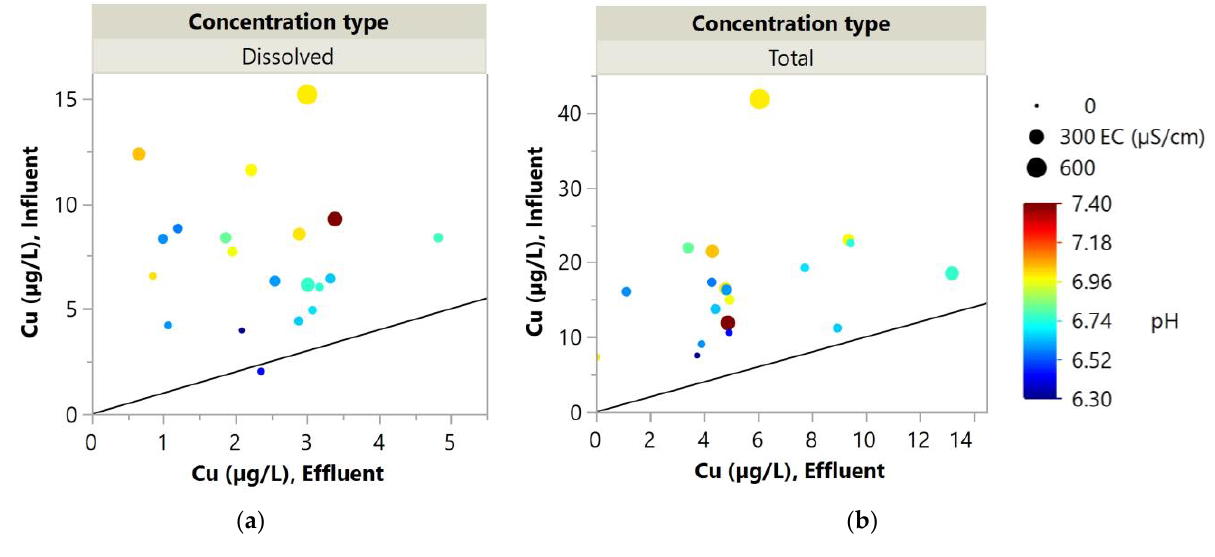
Figure 8. Bubble plots of ( a ) dissolved and ( b ) total Cu EMCs of both influent and effluent. The size of the bubbles represents the corresponding EC, while colors represent the corresponding pH. The 1:1 lines are included for reference, representing no change in the concentrations.